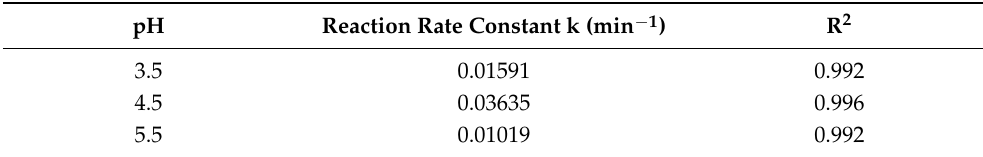
Table 2. Reaction rate constants for different